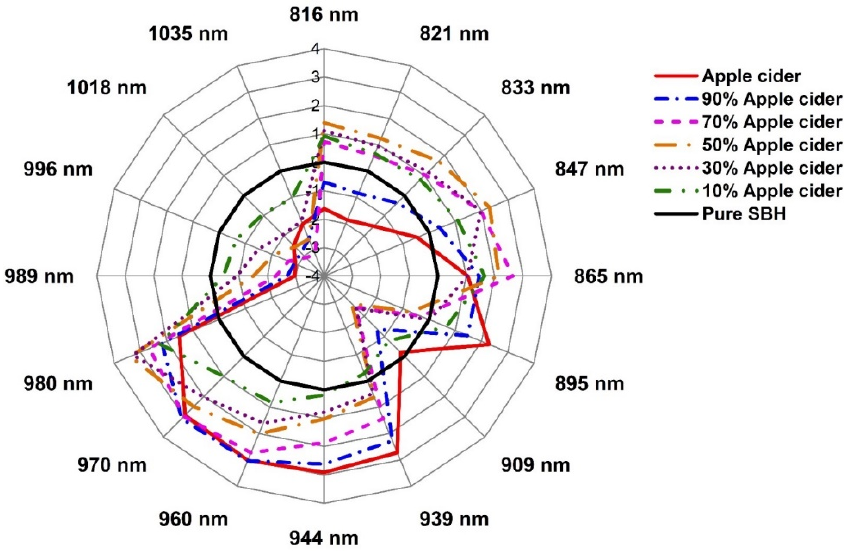
Figure 9. Aquagrams of pure SBH, apple cider vinegar, and adulterated SBH with various percentages of apple cider vinegar.